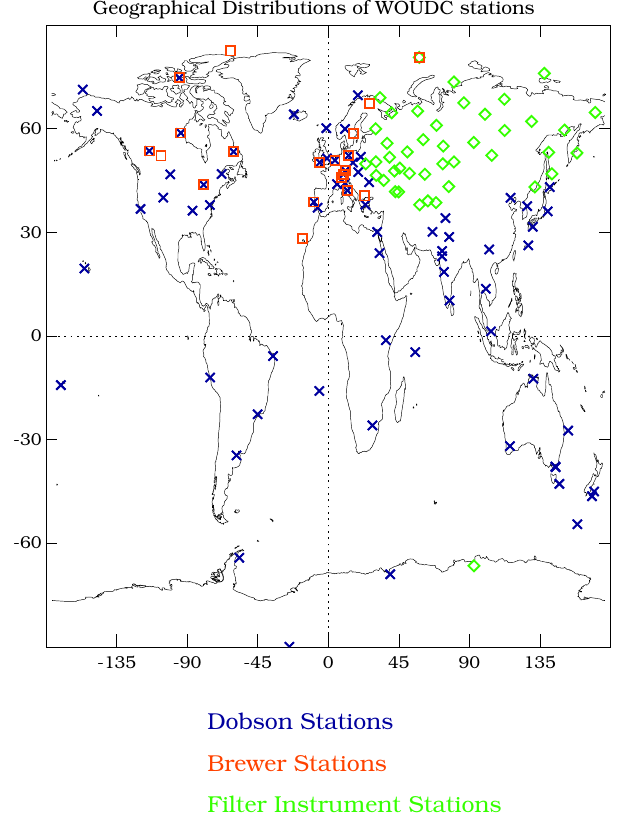
Figure 1. Geographical distributions of WOUDC ground stations. data in 1961 and remains the main source of ground-based ozone data for researchers. Global distributions of ground- based stations used in this study are depicted in Fig.